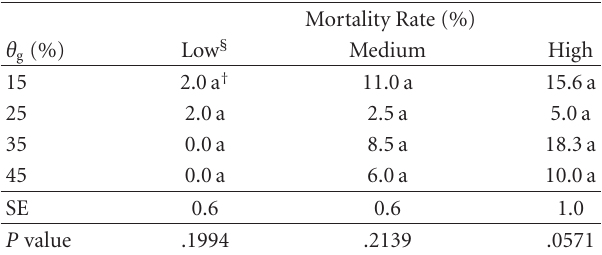
Table 1: Mean earthworm mortality in the low, medium, and high earthworm densities according to θ g (%)